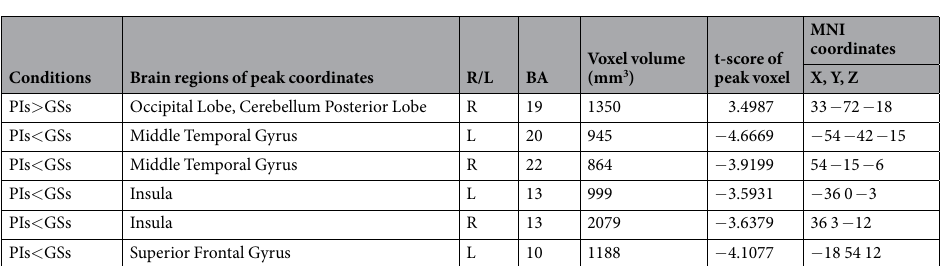
Table 2. The binarized degree centrality differences between PIs and GSs. Notes: Between-group differences in binarized degree centrality thresholded at r = 0.25. The statistical threshold was set at uncorrected voxel threshold of p < 0.01 with a minimum voxel volume threshold of 810 mm 3 . Abbreviations: PIs, patients with primary insomnia; GSs, good sleepers; R, right; L, left; BA, Brodmann’s area; MNI, montreal neurological institute.